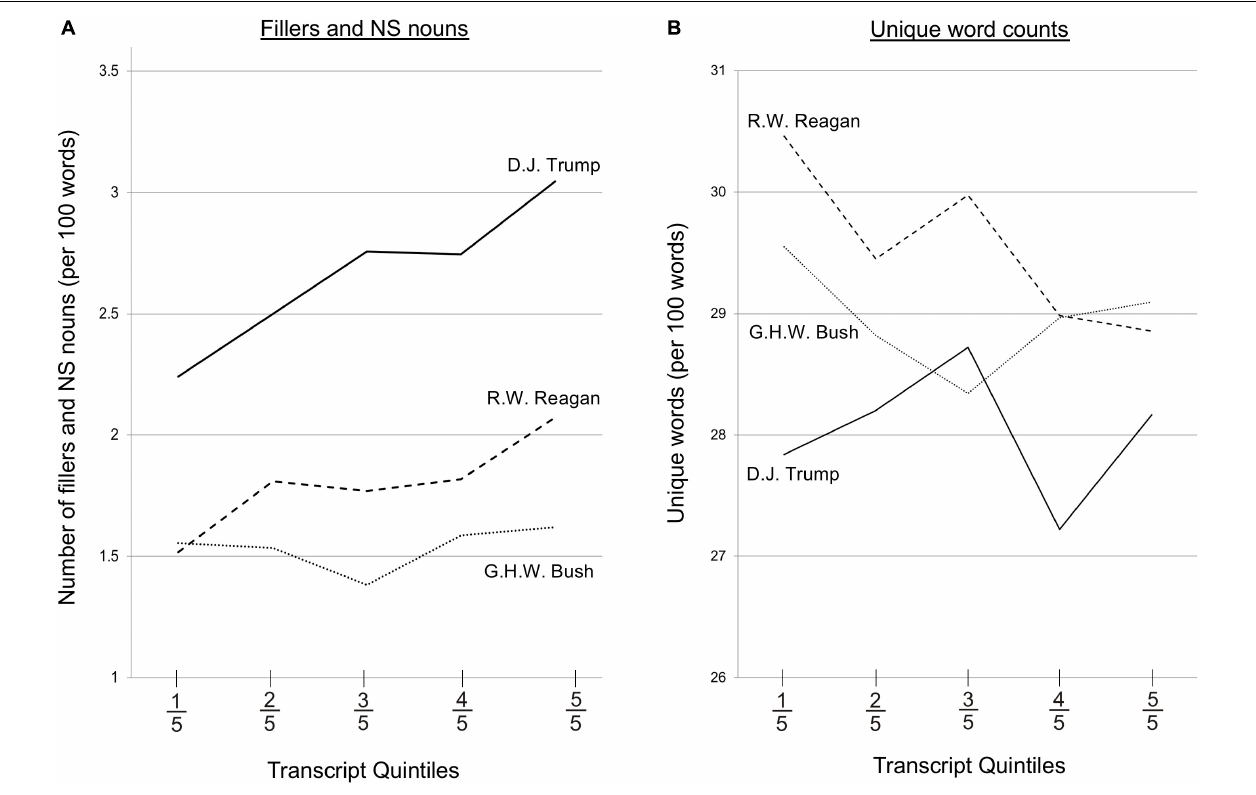
FIGURE 2 | Counts of fillers and non-specific nouns (A) and unique words (B) used by Presidents Donald J. Trump, Ronald W. Reagan, and George H.W. Bush. Data for R.W. Reagan and G.H.W. Bush are from Berisha et al. (2015). Counts are scaled to every 100 words (i.e., rate), and come from transcripts of unscripted responses to questions from the press with 1,400 (R.W. Reagan and G.H.W. Bush) and 1,000 (DJT) words. As each President has differing numbers of transcripts available, plotted values are averages from each fifth of the transcript set. Note that because Berisha et al. (2015) reported results for R.W. Reagan and G.H.W. Bush by transcript number (rather than month), the displayed transcript quintiles do not map linearly onto time (i.e., a given quintile can represent different durations). Thus, although the trends can be compared, caution is warranted in directly comparing individual quintiles across presidents. As in Berisha et al. (2015), values more than two standard deviations from the mean were removed for DJT: one above the mean filler and NS noun count, and two below the mean unique word count. For unique word count (B) , care should be taken not to over-interpret absolute differences between individuals as DJT transcripts are shorter (1,000 vs. 1,400 words), which can give higher unique-word estimates (i.e., the DJT values are relatively inflated compared to the other Presidents; Le et al.,